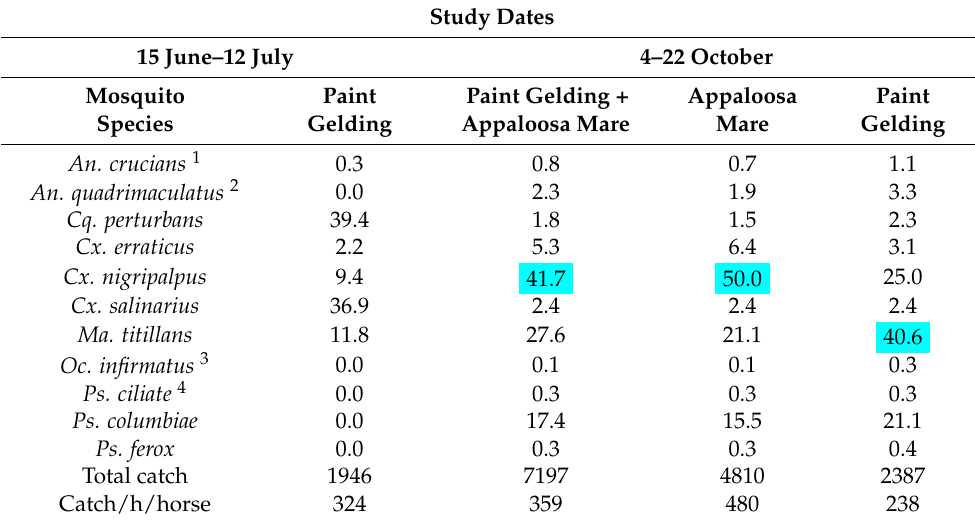
Table 5. Percentage of mosquito species and total number and number/h/horse of mosquitoes vacuumed from horses during two 2004 studies at the UF Horse Teaching Unit, Gainesville, FL, USA ( n = 6). Species captured in the highest percentage by the Paint gelding and Appaloosa mare together and separately in the October study are